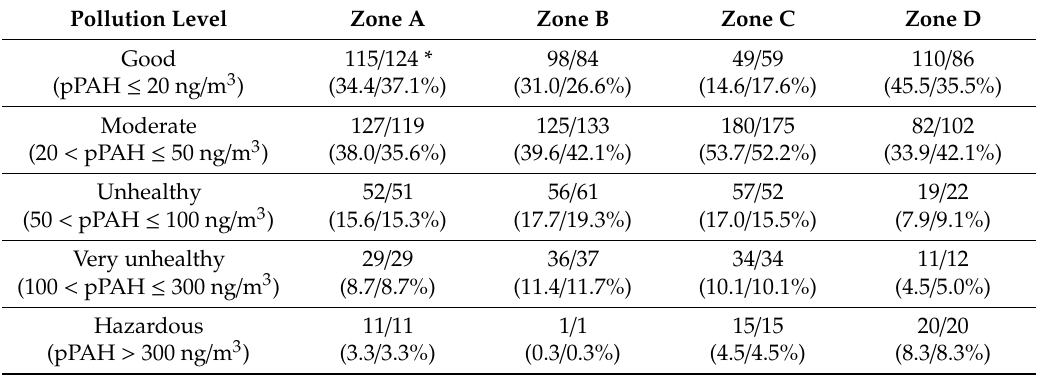
Table 4. Number of cells categorized into five levels of pPAH concentrations for zones A, B, C, and